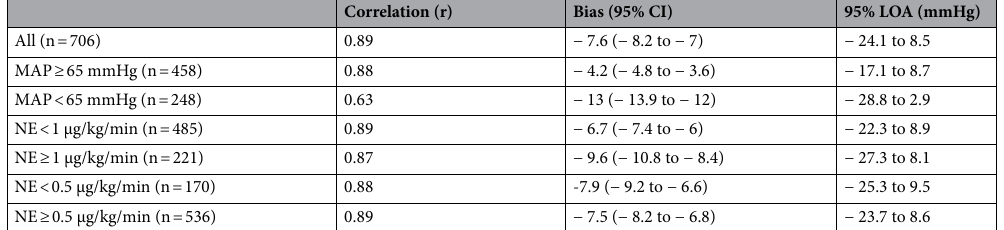
Table 2. The correlation and agreement between MAP from radial and femoral arteries in all of the population and each subgroup. CI: confident interval, LOA: limit of agreement, MAP: mean arterial pressure, NE: